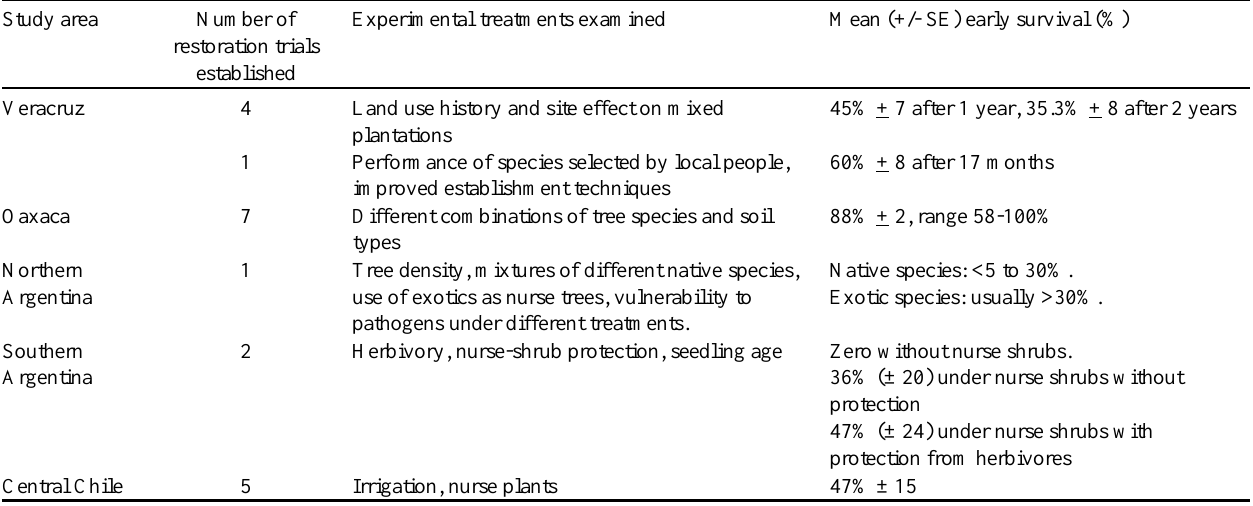
Table 4 . Summary of restoration trials and experiments undertaken during the ReForLan project.